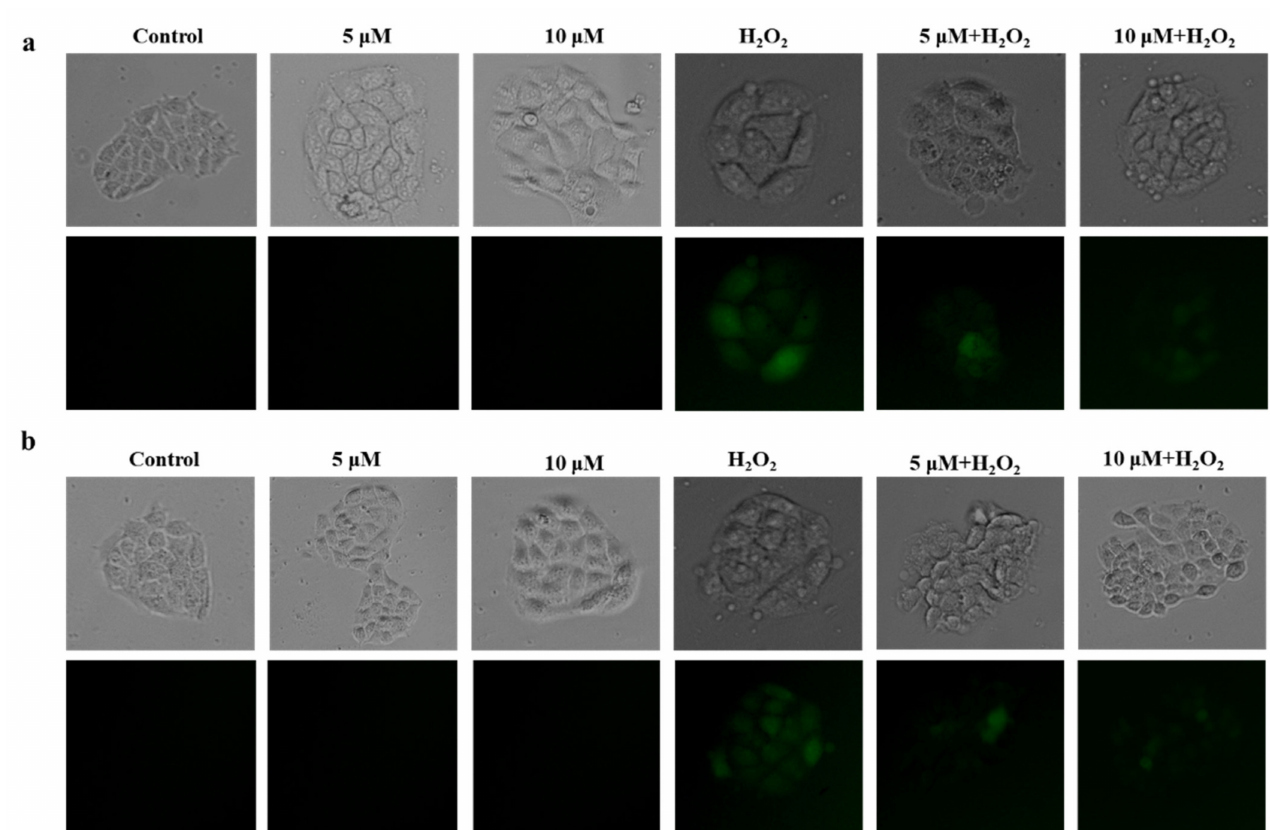
Figure 4. 3b-9 and 4b-3 reduces the ROS level in HaCaT cells. HaCaT cells were pretreated with 3b-9 ( a ) and 4b-3 ( b ) for 24 h and then were exposed to H 2 O 2 (500 µ M) for 1 h. Cells were incubated with DCFH-DA (10 µ M) for 20 min, and the ROS level were observed with fluorescence